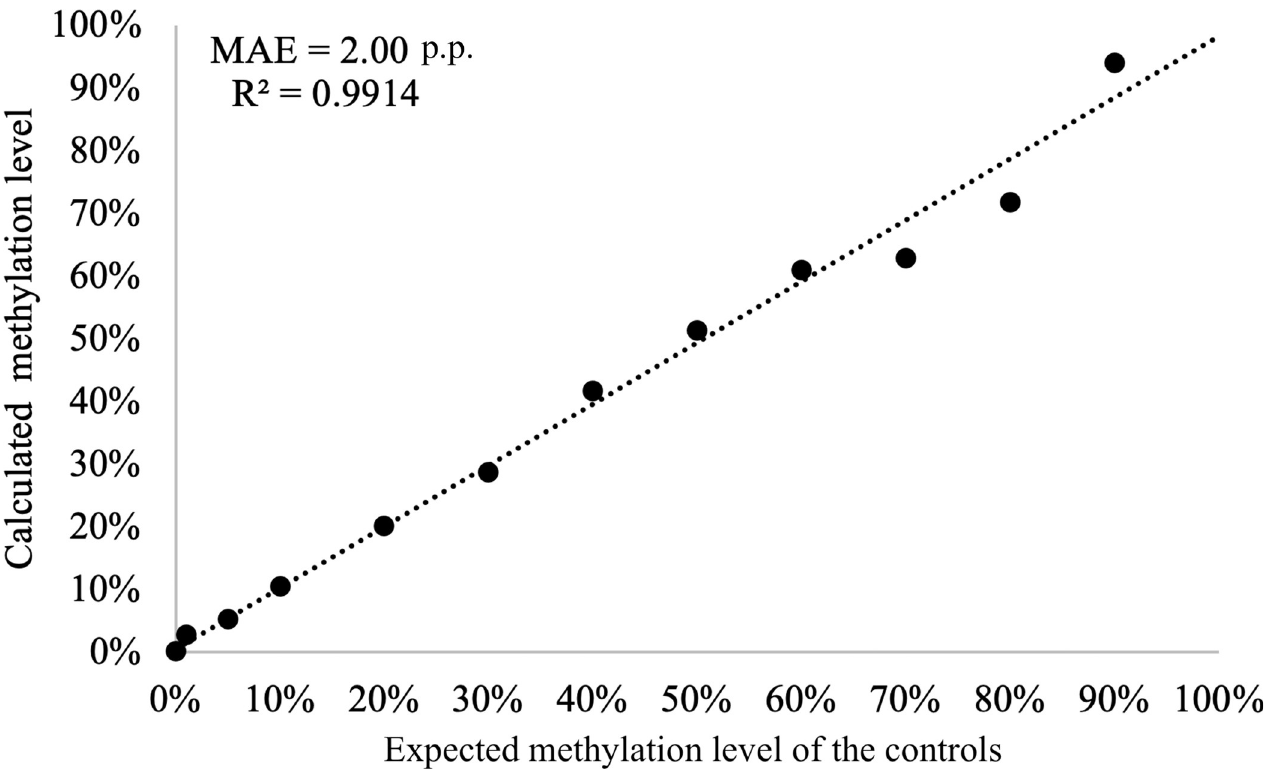
Fig 5. Goodness of fit analyses using the Eq 3. The AUC predicted by the Eq 3 and empirical data in this experiment fit with R 2 = 0.9914 and MAE = 2.00 percent point. All data points were plotted as a mean of triplicate samples.